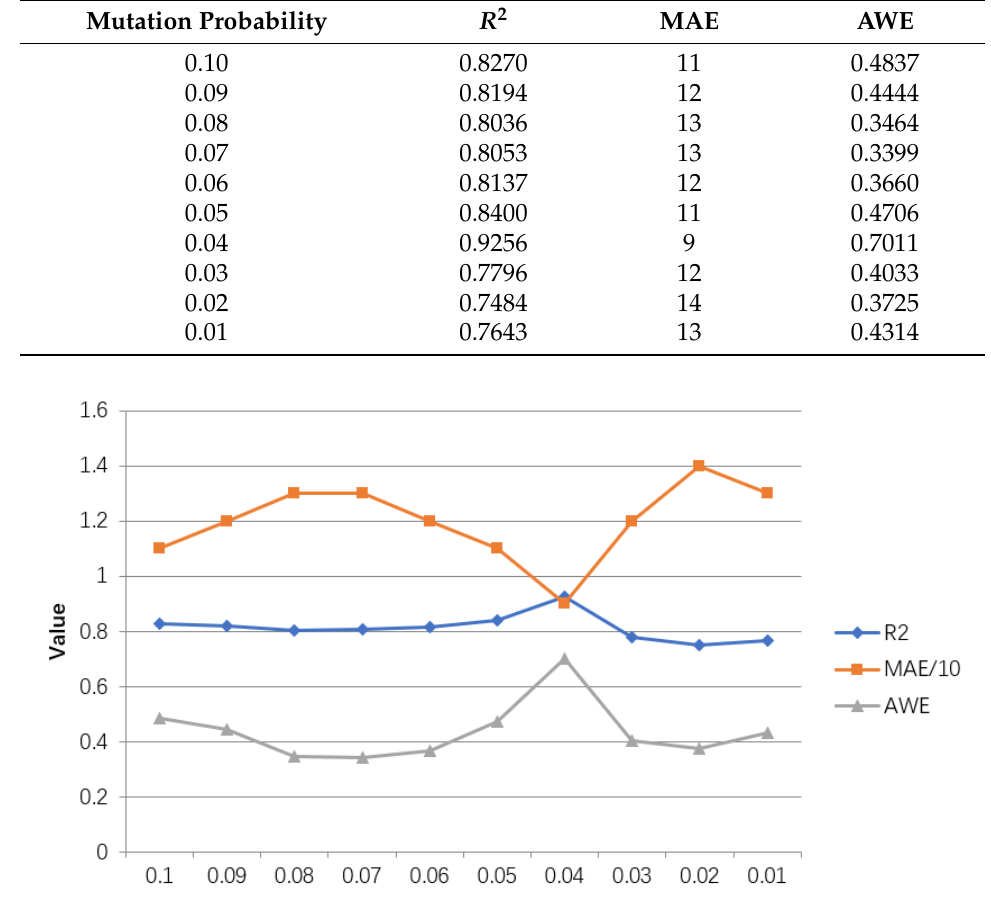
Table 8. Adjustment evaluation table of hyperparameter mutation probability in GA-BP model.